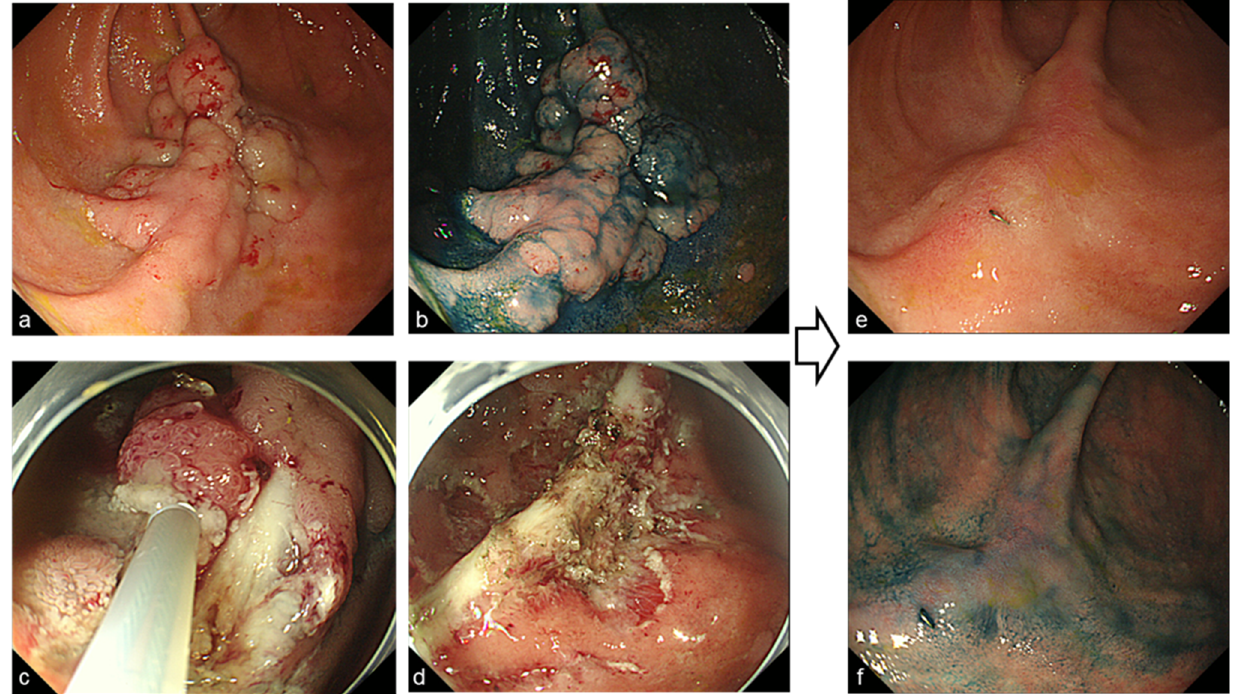
Figure 2. Endoscopic images before and after endoscopic piece meal resection (EPMR) for laterally spreading adenoma more than 5 cm (( a – d ) before treatment, ( e , f ) 6 months after EPMR).